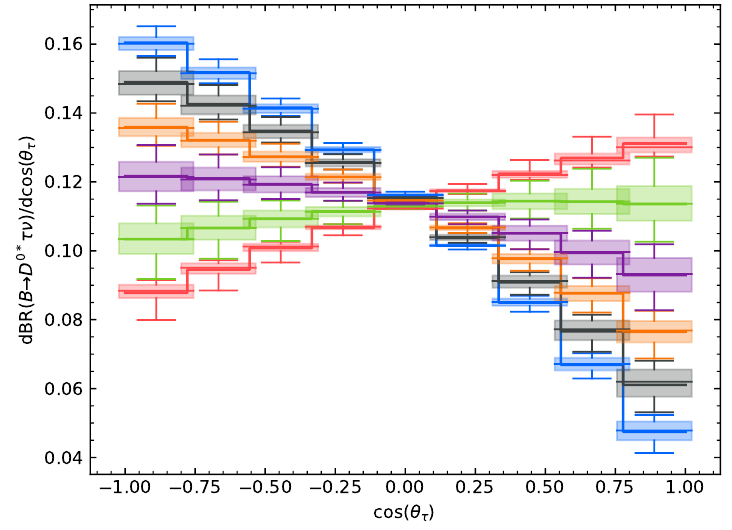
Figure 2 . The distributions of the observable dBR( B ! D 0 (cid:3) (cid:28)(cid:23) ) = d(cos( (cid:18) (cid:28) )) for the six di(cid:11)erent clusters (with colours matching these of (cid:12)gure 1). The histograms corresponding to the the BPs are shown as solid lines. The boxes extend from the upper to the lower quartile of the distribution of the bin contents within a cluster and a horizontal line indicates the median. Whiskers are used to further indicate the span of the data, covering six times the interquartile